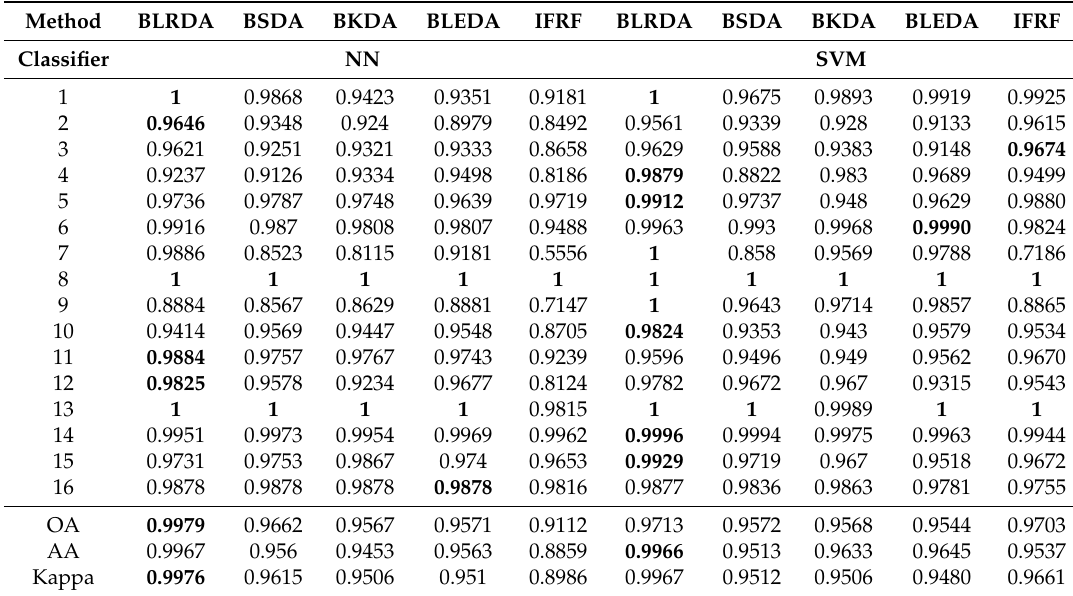
Table 2. Supervised and semi-supervised classification results for the Indian Pines image. BLRDA, Block Low-Rank Discriminant Analysis. BSDA, Block Sparse Representation Discriminant Analysis. Discriminant Analysis. IFRF, Image Fusion and Recursive Filtering.